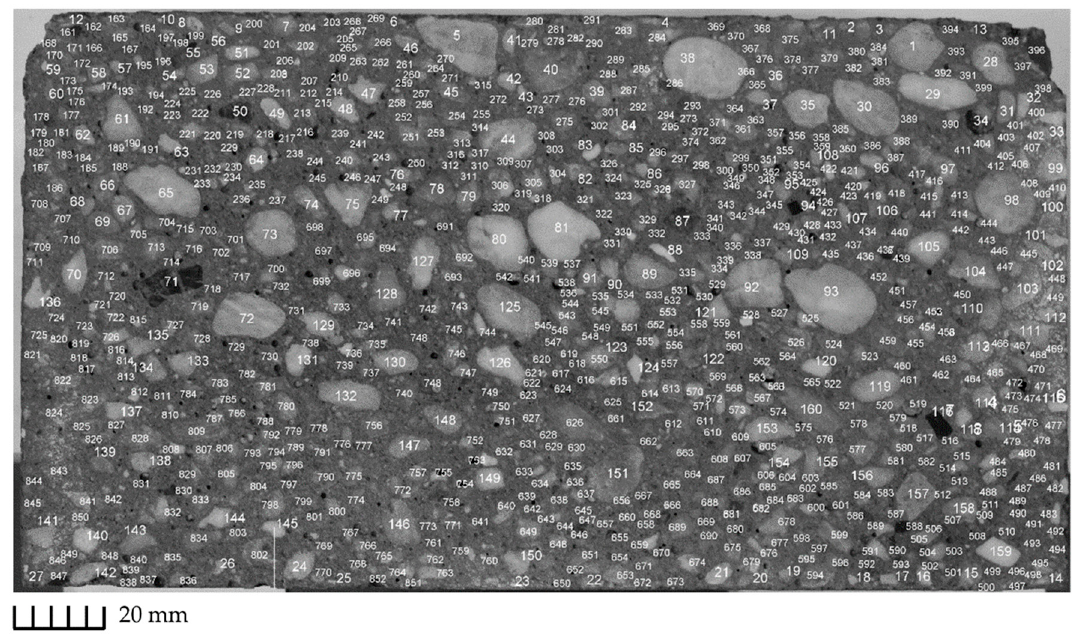
Figure 6. Visible particles larger than one mm for determination of the particle distribution for S47.